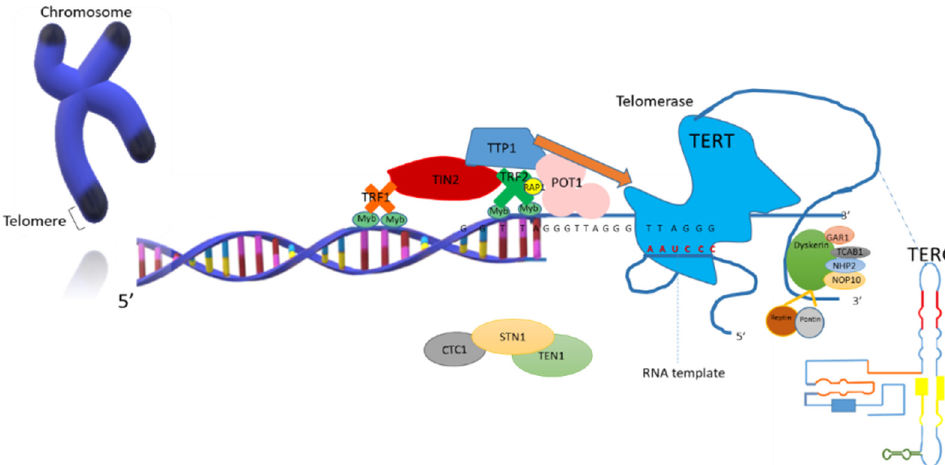
Figure 2. Scheme of the telomerase complex, consisting of two main subunits: telomerase RNA (TERC) that contains the RNA template region, and telomerase catalytic subunit (TERT), which is responsible for adding the new segment. Adrenocortical dysplasia protein homolog (TPP1) acts as a telomerase recruiter. In addition, the accessory proteins for the enzyme to be fully functional are shown: Dyskerin, H/ACA ribonucleoprotein complex subunit 1 (GAR1), telomerase Cajal body protein 1 (TCAB1), H/ACA ribonucleoprotein complex subunit 2 (NHP2), and and H/ACA ribonucleoprotein subunit 3 (NOP10). The pontin and reptin proteins are in charge of its remodeling and assembly.